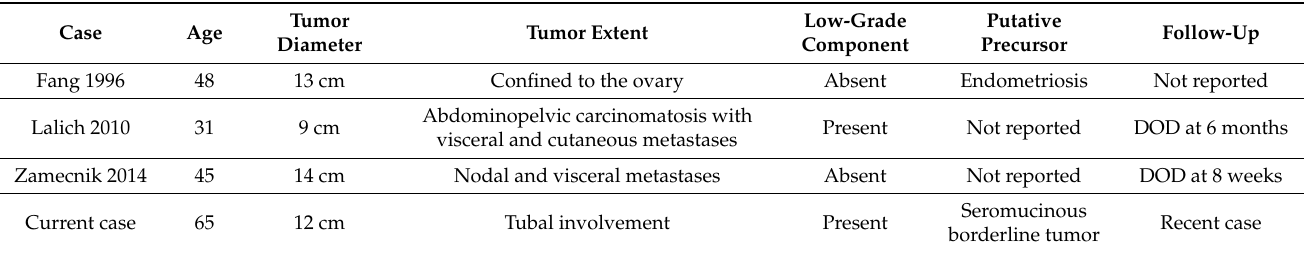
Table 1. Clinicopathological features of the current case and previously published cases of putative ovarian